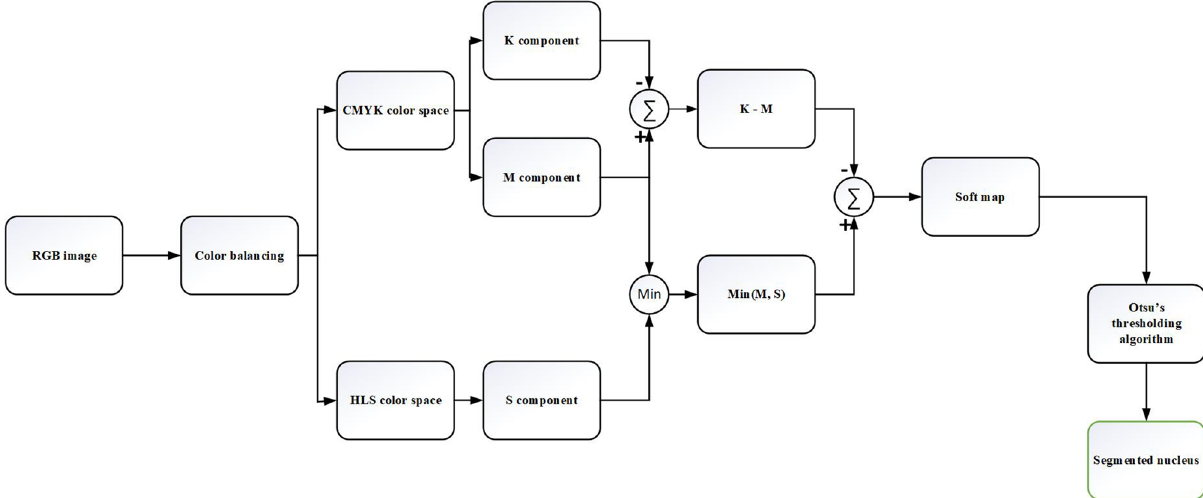
Figure 4. The block diagram of the nucleus segmentation method.